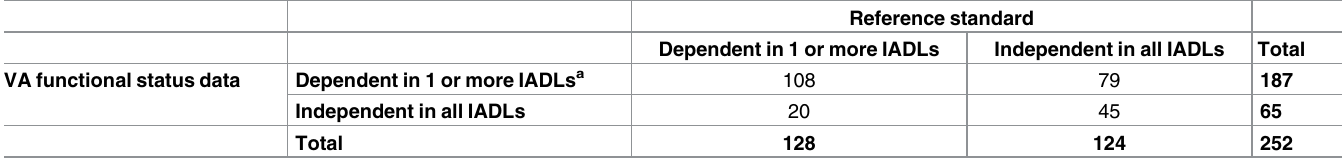
Table 5. Agreement of VA functional status data with the referencestandard of research-collected data for assessing dependence in instrumental activities of daily living.